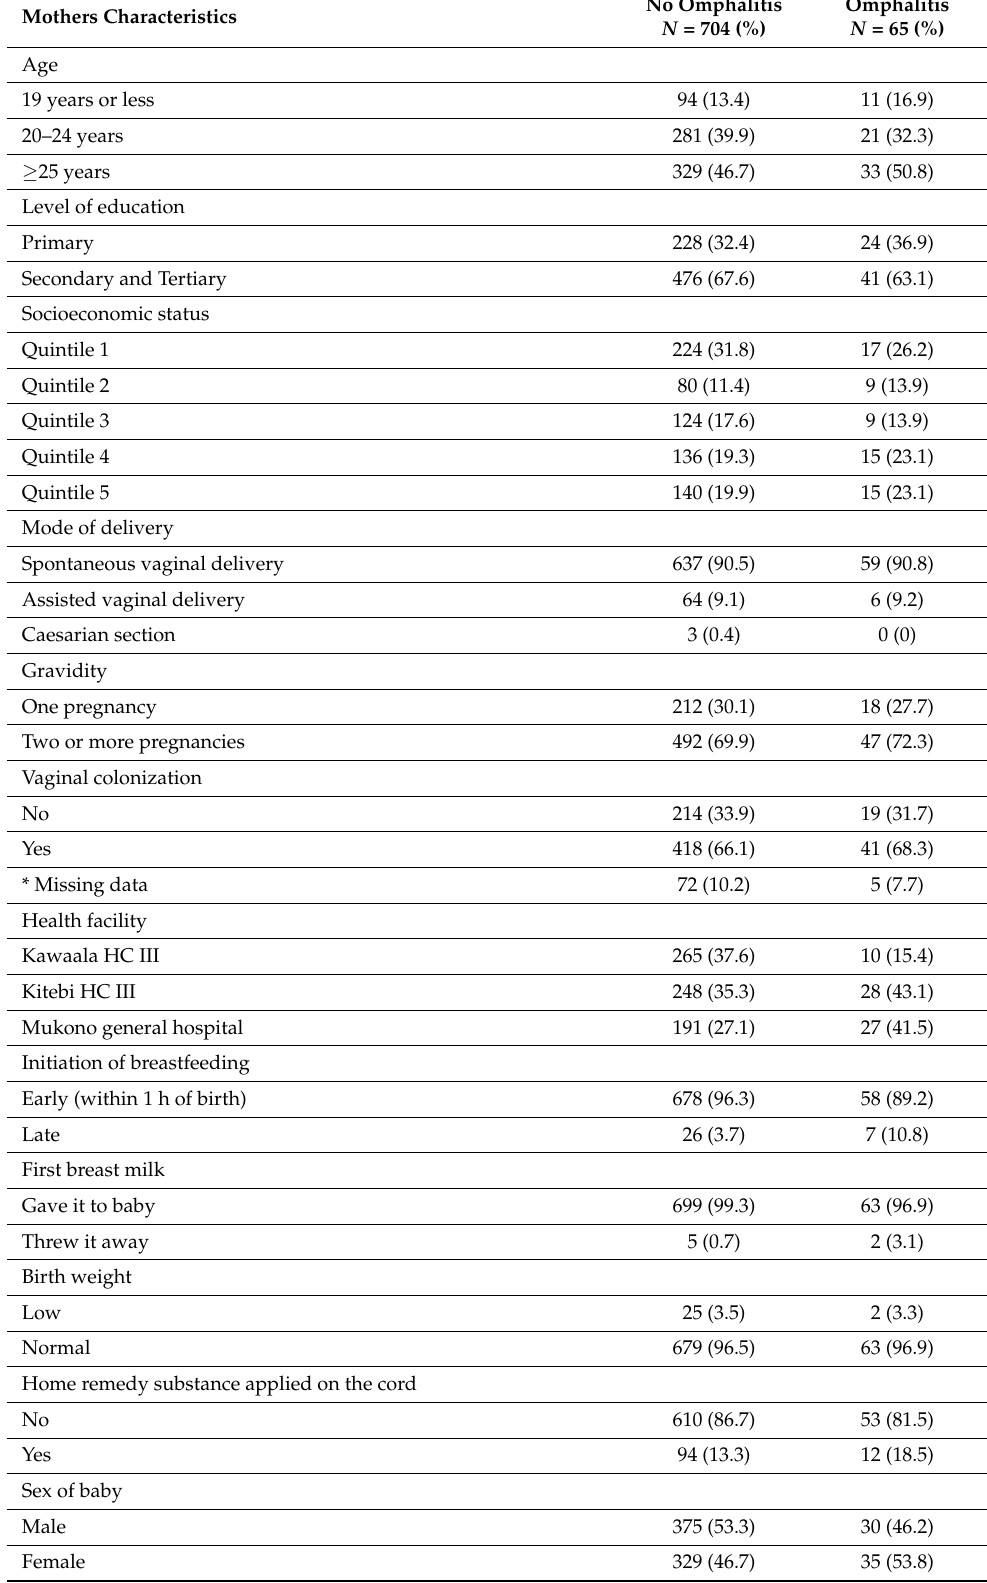
Table 1. Distribution of social-demographic characteristics among study participants with and without omphalitis at the three study sites in central